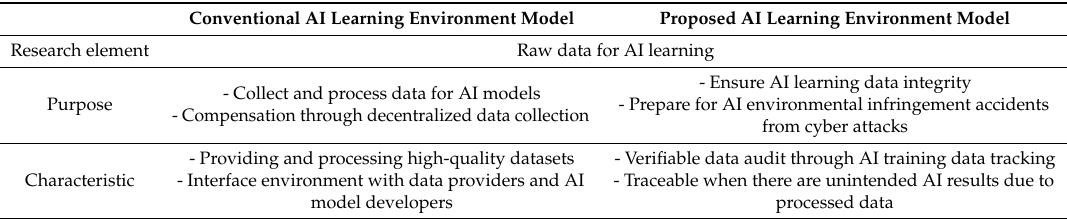
Table 3. Comparative analysis with existing